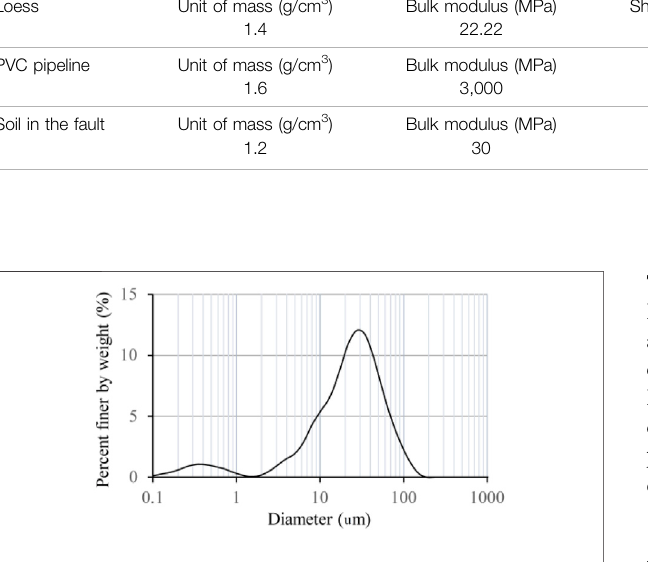
FIGURE 4 | Particle size distribution of the experimental loess.